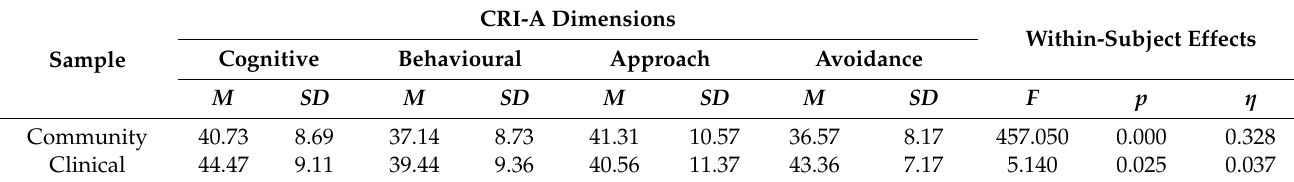
Table 4. Repeated-measures analysis between the four CRI-A dimensions by group (community/clinical). CRI-A Dimensions Within-Subject Effects Cognitive Behavioural Approach Avoidance Sample M η Community Clinical The repeated-measures analysis showed significant differences ( p < 0.05) between the scores obtained in the four dimensions of the CRI-A in both groups (Table 4). The pairwise comparisons indicated the following: (1) In the community group, significantly higher scores ( p < 0.001) were obtained in the cognitive and approach dimensions